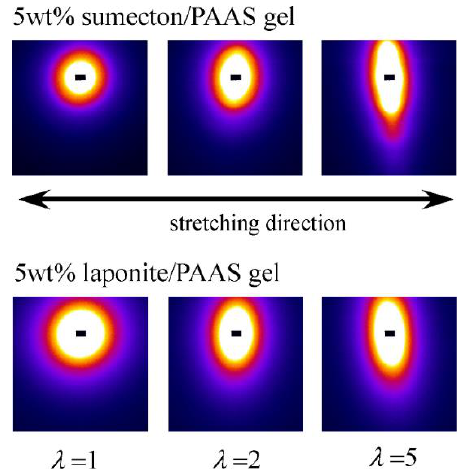
Figure 6. SAXS images for 5 wt % sumecton/PAAS blend hydrogels (upper) and 5 wt % laponite/PAAS blend hydrogels (lower).